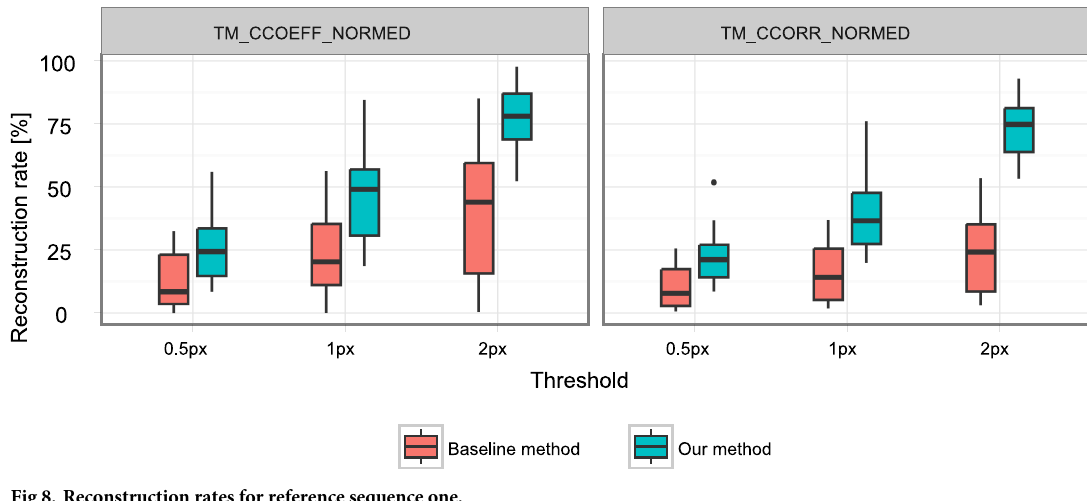
Fig 8. Reconstruction rates for reference sequence